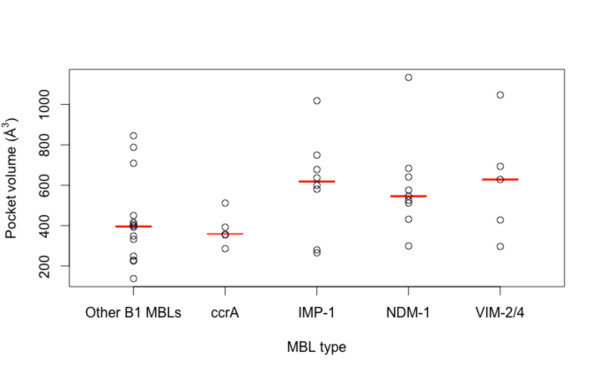
Estimated pocket volumes of the binding site for ccrA, IMP-1, VIM, NDM-1 and other B1 MBLs. Boxplots show the distribution of volume for various MBL binding sites; while the plasmid-bourne MBLs (IMP-1, NDM-1, VIM) share similar volume sizes, with fluctuation, ccrA and other B1 MBLs have a distinctly smaller site. Estimates were calculated using CASTp [23]. Data for generating these plots are from Additional file 3.